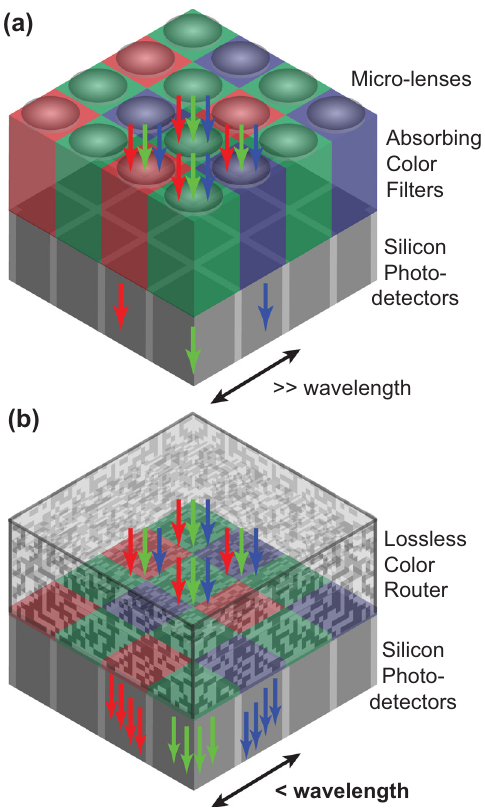
Figure 1: Subwavelength Bayer RGB color router. (a) Traditional color functionality in image sensors based on a CFA with red (R), green (G), and Blue (B) absorbing color fi lters in an RGGB Bayer mosaic layout and a micro-lens array on top of silicon photodetectors. (b) Lossless color router in a 2 by 2 pixel RGGB Bayer layout replaces both the CFA and the micro-lens